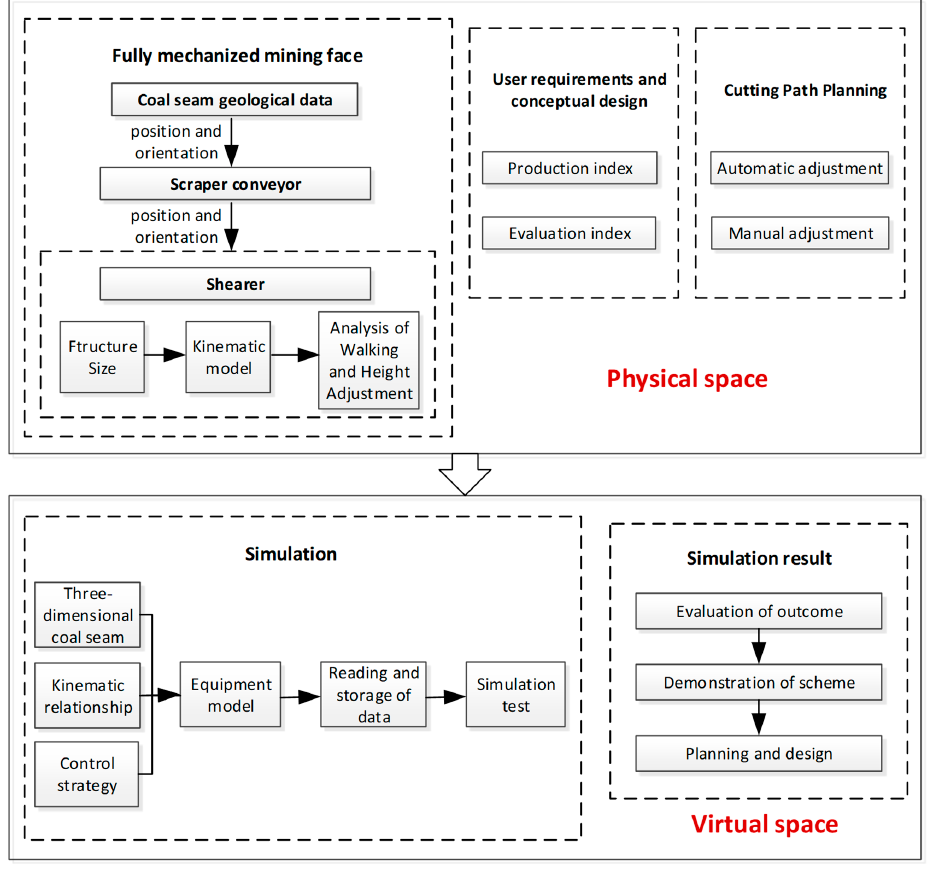
Figure 1. Overall framework.